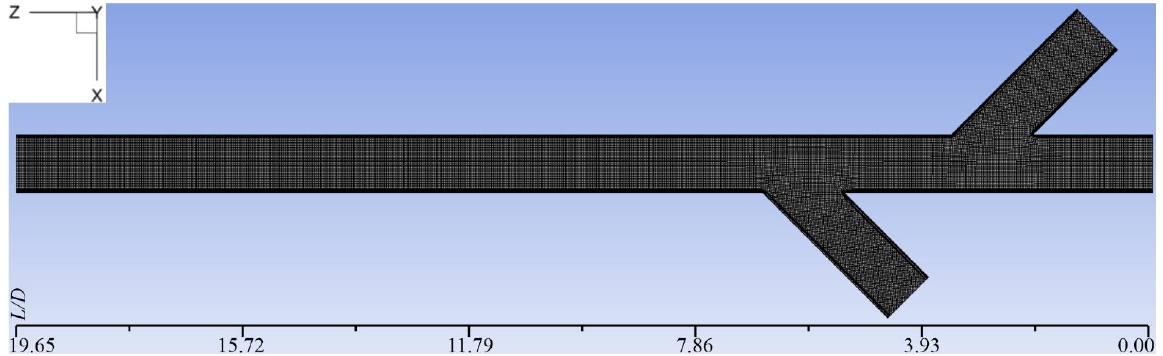
Figure 2. Refinement of the Cut-cell type hexahedral mesh for the injectors.